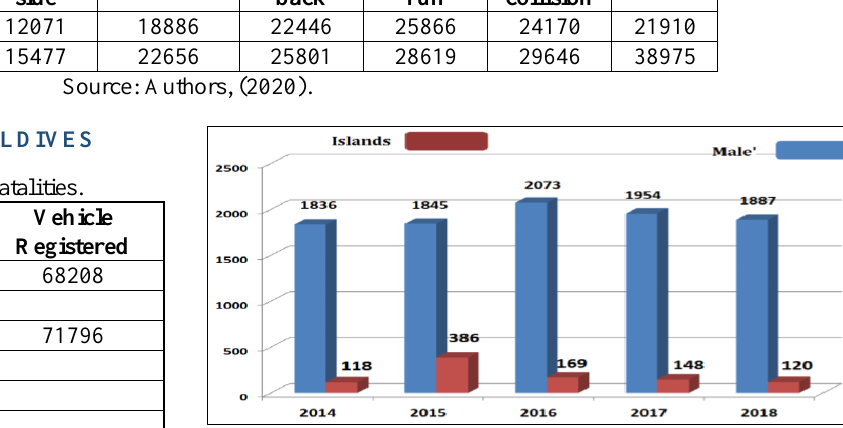
Figure 8: Road Accidents-5 years’ data (2014-2018). Source: Authors,